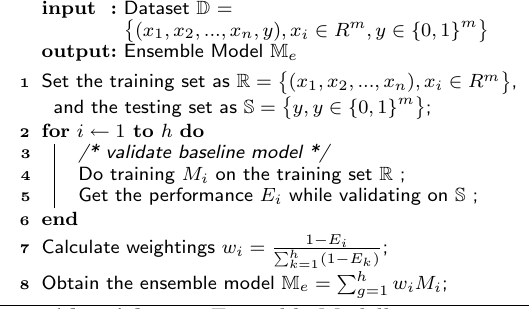
Algorithm 1: Ensemble Modelling